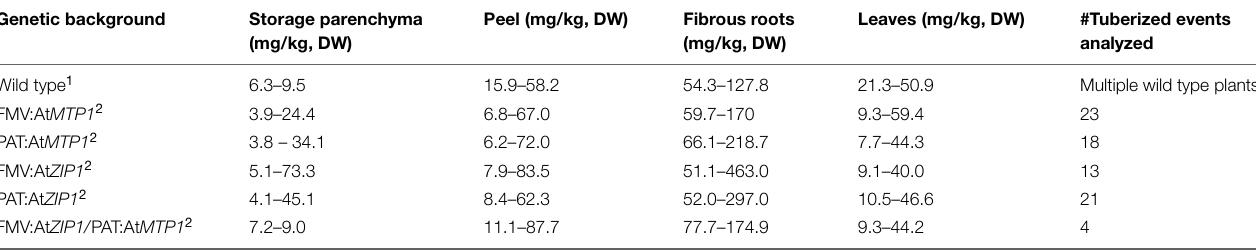
TABLE 1 | Zinc concentrations in plant tissues from plants grown in grow chambers. Genetic